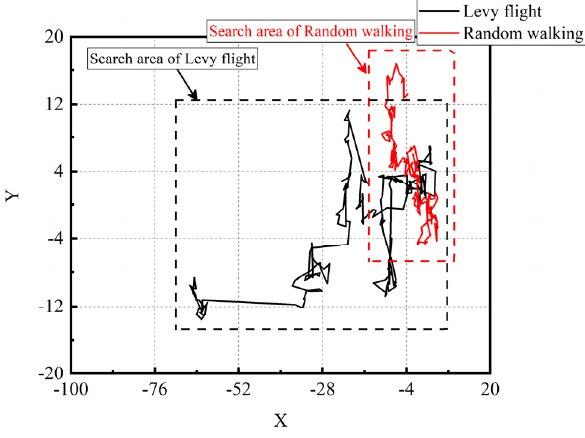
Figure 8. Comparison of Levy flight and random walking.